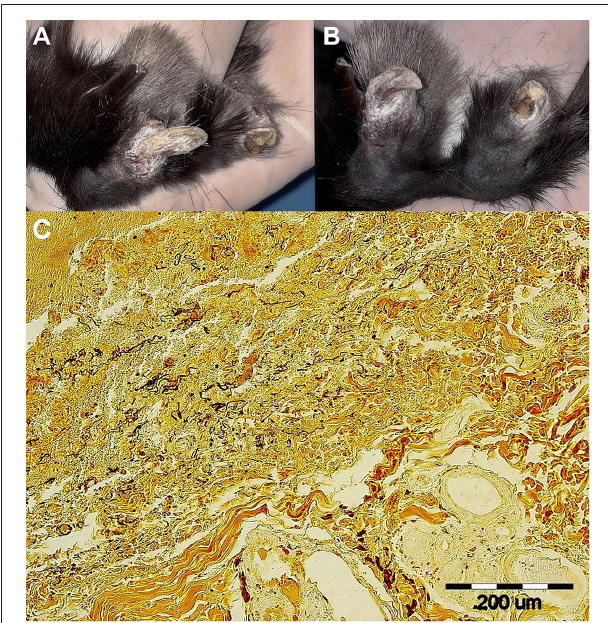
FIGURE 1 | Skin lesions on the right hindlimb of a pet rabbit with syphilis. ( A , left) Detailed view of healthy (2nd) and syphilis affected (3rd) nail and toe. ( B , right) Note the fractured and deformed claws/nails on both the 3rd and 4th toes. White scaly lesions were seen on both affected claws/nails, the eponychium, and the distal parts of terminal phalanges. ( C , bottom) Wartin-Starry silver stain highlights spirochetes in dermis, magnification 200 × . Histopathological examination of the lesion in the area of claw and surrounding connective dermal tissue showed presence of proliferating fibrovascular tissue, moderate mixed inflammatory infiltrate with predominance of lymphocytes, plasma cells, and macrophages, with admixture of lesser number of neutrophils. There was superficial erosion of epithelium, areas of serocellular crusts, focally small hemorrhages and deposits of hemosiderin in dermis. There were no visible bacteria seen in tissue sections stained with HE. Silver staining method (Warthin-Starry) revealed presence of numerous typical spiral and thread-like organisms in epidermis and dermis within the area of inflammatory